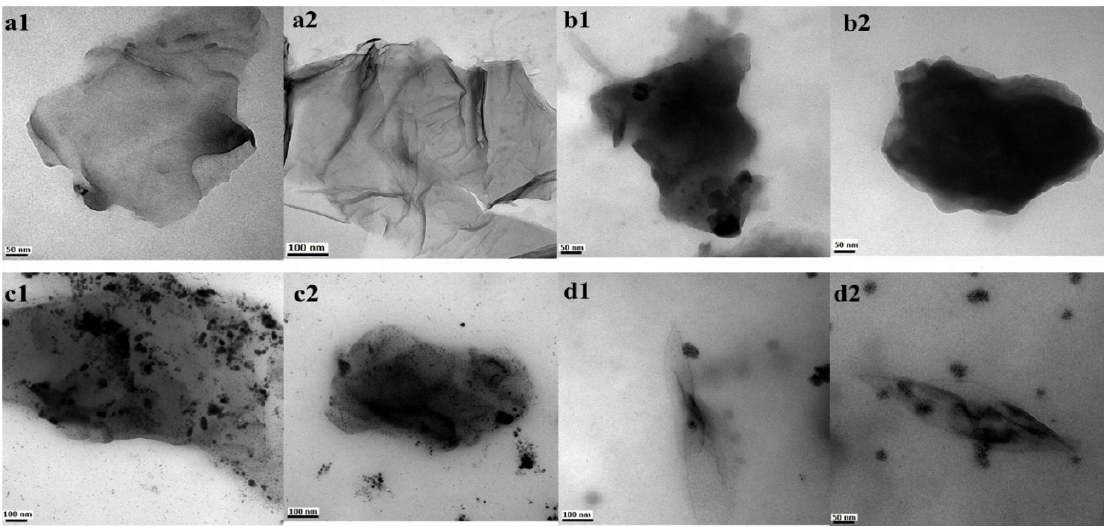
Figure 1. Transmission electron microscope (TEM) images of: ( a ) GEO, ( b ) CGEO1, ( c ) CGEO2 and ( d ) CGEO3 (see Table